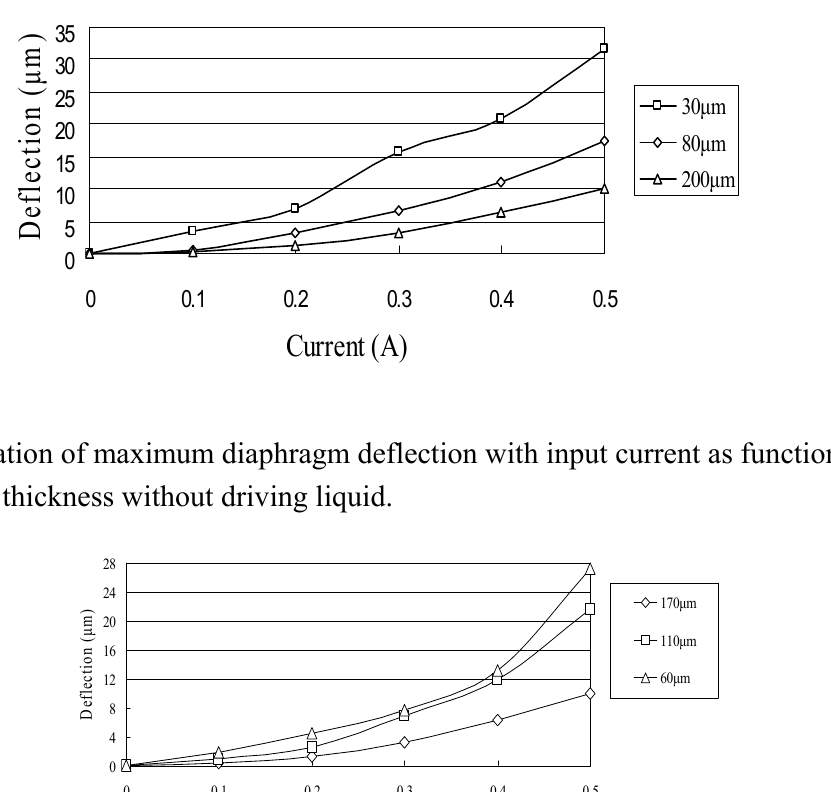
Figure 7. Variation of maximum diaphragm deflection with input current as function of PDMS diaphragm thickness without driving liquid.